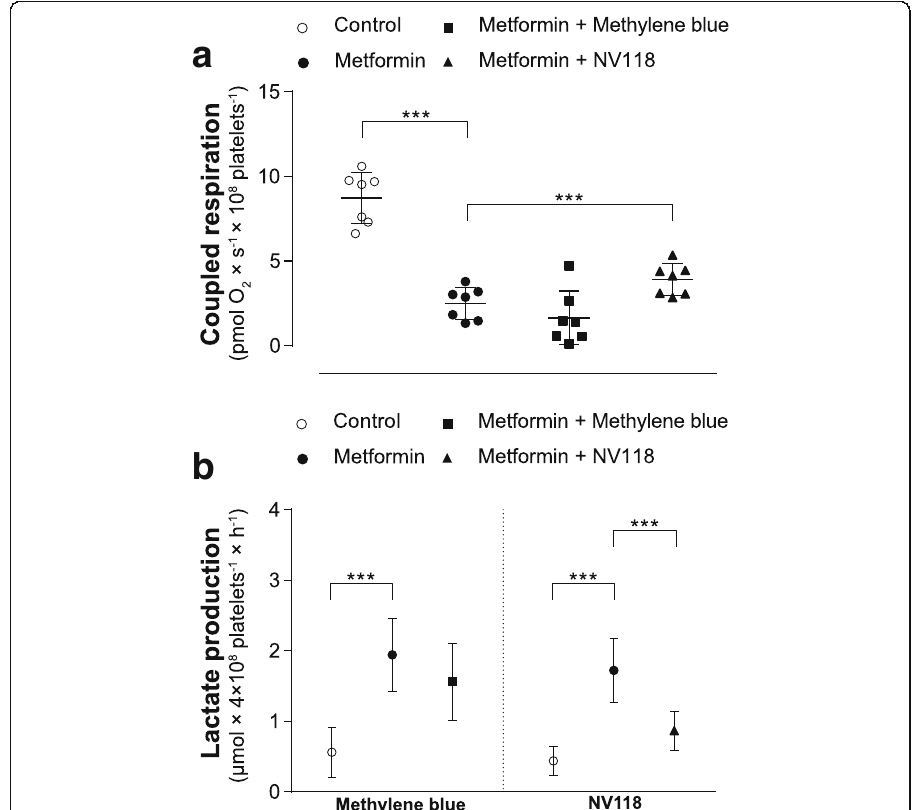
Fig. 3 Effect of methylene blue and NV118 on coupled respiration and lactate production in metformin- intoxicated human platelets. a Mitochondrial respiration was measured in human platelets with mitochondrial dysfunction induced by 60 min exposure to metformin (black circle; 50 mM). After subsequent addition of methylene blue (10 μ M, black square) or the cell-permeable succinate prodrug NV118 (250 μ M, black triangle), mitochondrial respiration due to coupled phosphorylation, here referred to as coupled respiration, was evaluated by addition of the ATP-synthase inhibitor oligomycin (1 μ g/ml) to block the phosphorylation pathway, and calculated as the difference in respiration before and after the inhibition of the ATP-synthase. Subsequently, the complex III inhibitor antimycin A (1 μ g/ml) followed by the complex IV inhibitor sodium azide (10 mM) were added. Control experiments were performed without the addition of oligomycin to account for background drift of oxygen consumption. A vehicle control to metformin was run with each experiment (white circle). b Lactate production of human platelets incubated with metformin (10 mM, black circle) was measured every 30 min over 4 h with or without co-treatment of methylene blue (10 μ M, single dose, black square) or NV118 (250 μ M, every 30 min, black triangle) starting at 60 min. A vehicle control was run with each experiment (white circle). Data are expressed as individual scatter plot and mean±SD ( a ) or mean±SD ( b ). All experiments were performed with n =7, with exception of the control and metformin group of the lactate production assay run with methylene blue ( n =9) ( b ). One-way ANOVA with Dunnet post hoc test was used. *** p <0.001, compared to